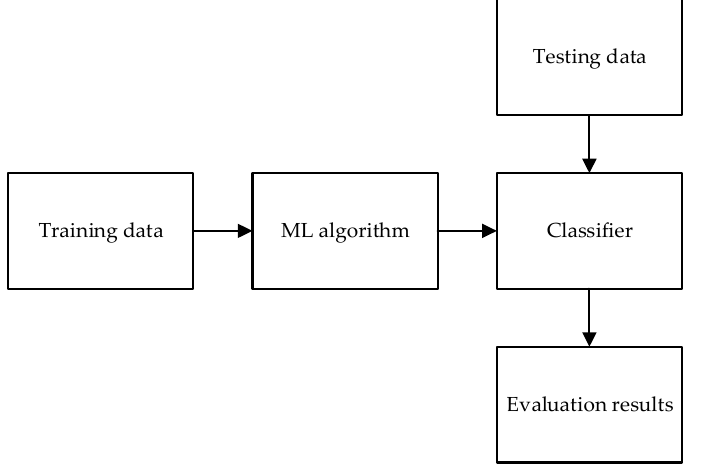
Figure 2. Flow chart of machine learning related for the proposed mixed models in this study.